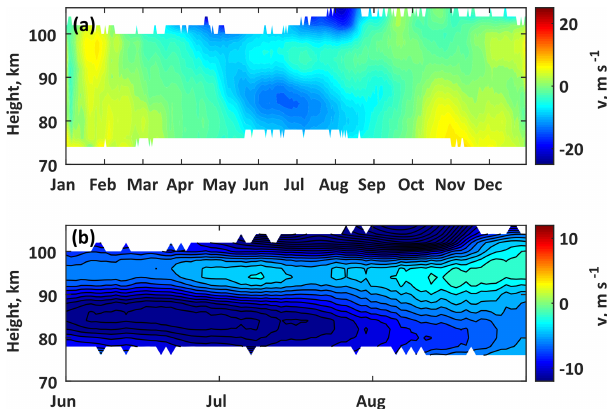
Figure 2. Climatology of meridional mean winds obtained from Juliusruh meteor radar observations over years 2007–2016. Panel (a) shows climatology for the entire year; panel (b) shows climatology for summer months only.